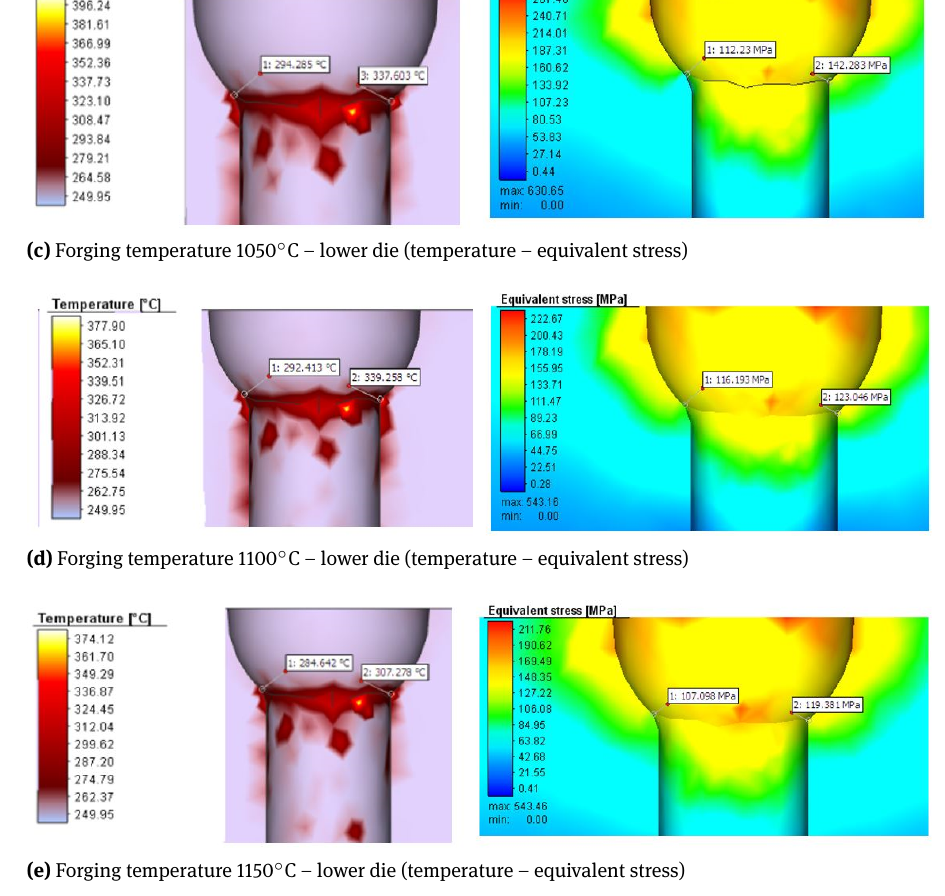
Figure 7: Analysis of temperature and equivalent stress of lower die at points 1 and